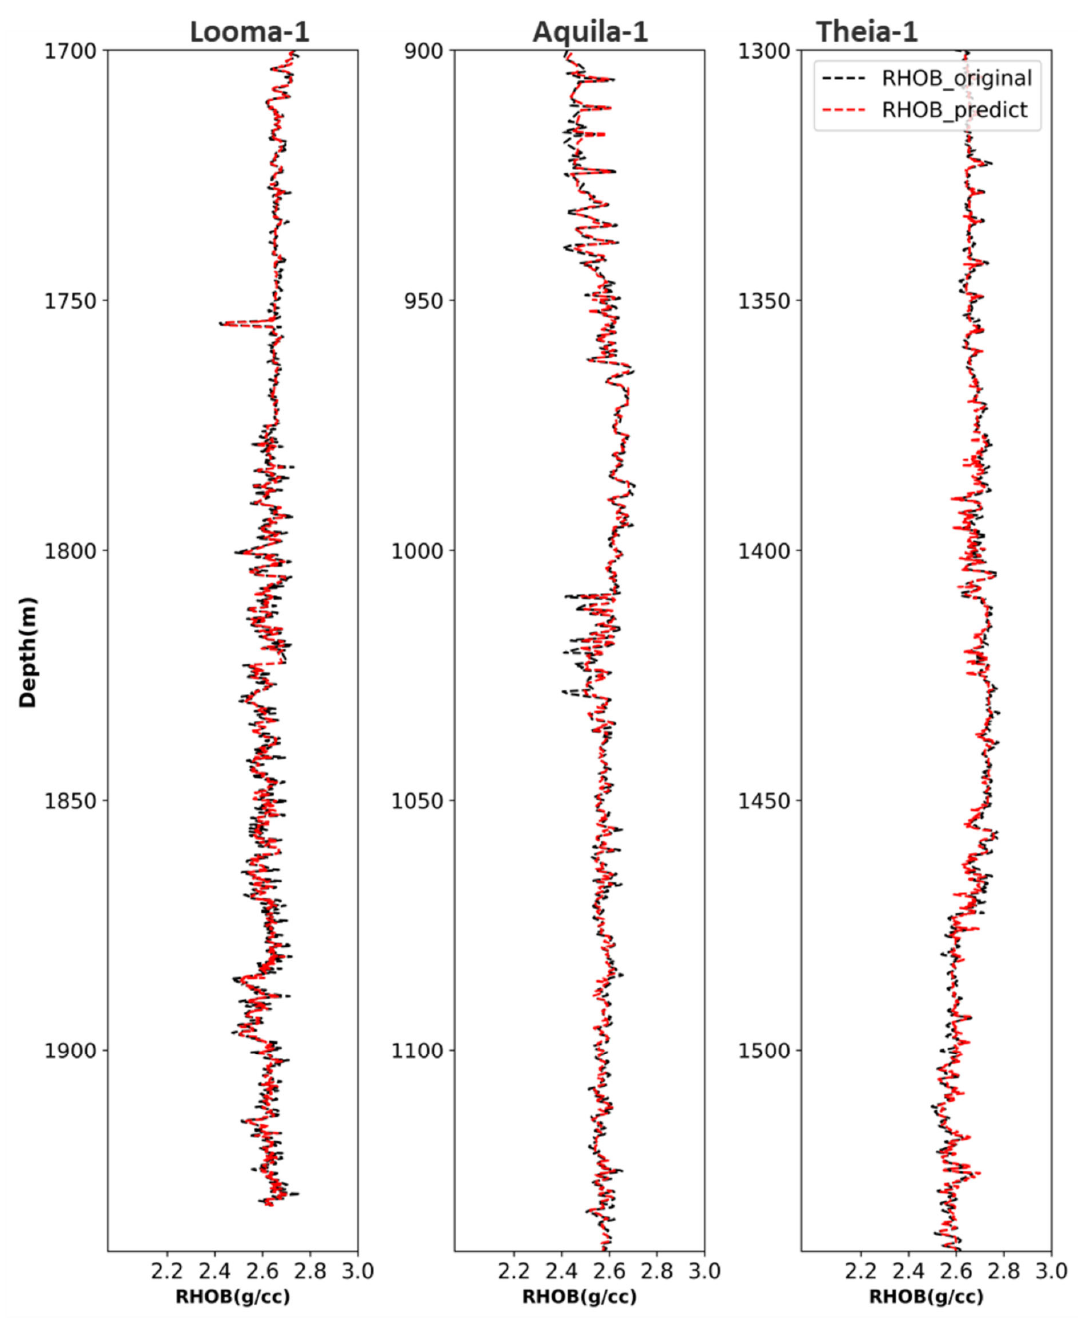
Figure 10. Comparison of actual bulk density and random forest predicted bulk density log on three wells. Blind well Looma ‐ 1 is showing prediction accuracy index R 2 of 0.84. The remaining two wells (Aquila ‐ 1 and Theia ‐ 1) are part of the training and validation data set. Predicted RHOB (red in color) are overlaid on the original RHOB log of Aquila ‐ 1 and Theia ‐